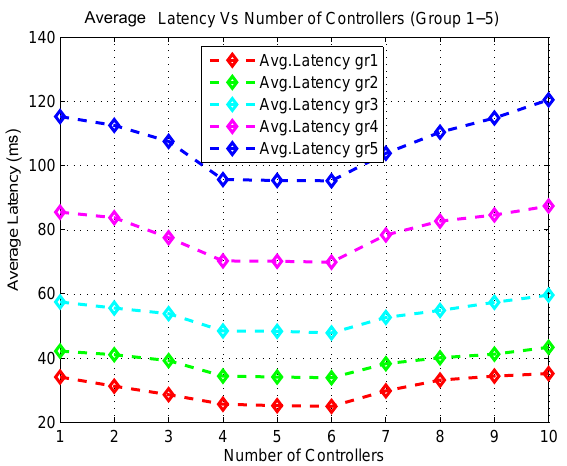
Figure 7. Average Latency with varying number of